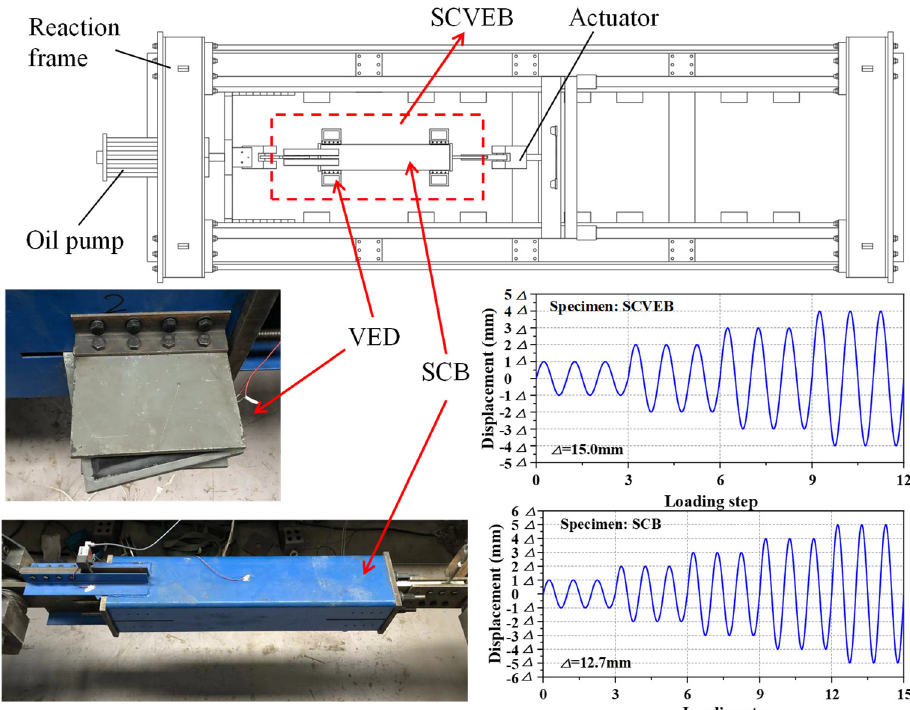
Figure 11. Test arrangement and observation.